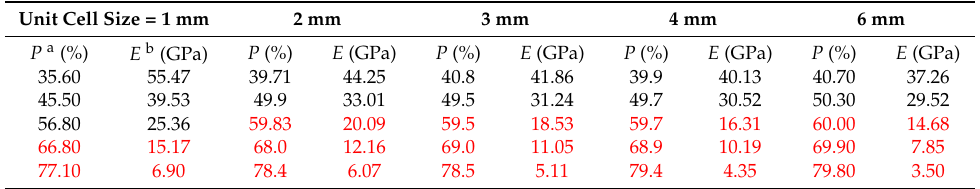
Table 2. Dynamic elastic modulus and porosity of porous structures measured by resonant frequency and damping analyzer